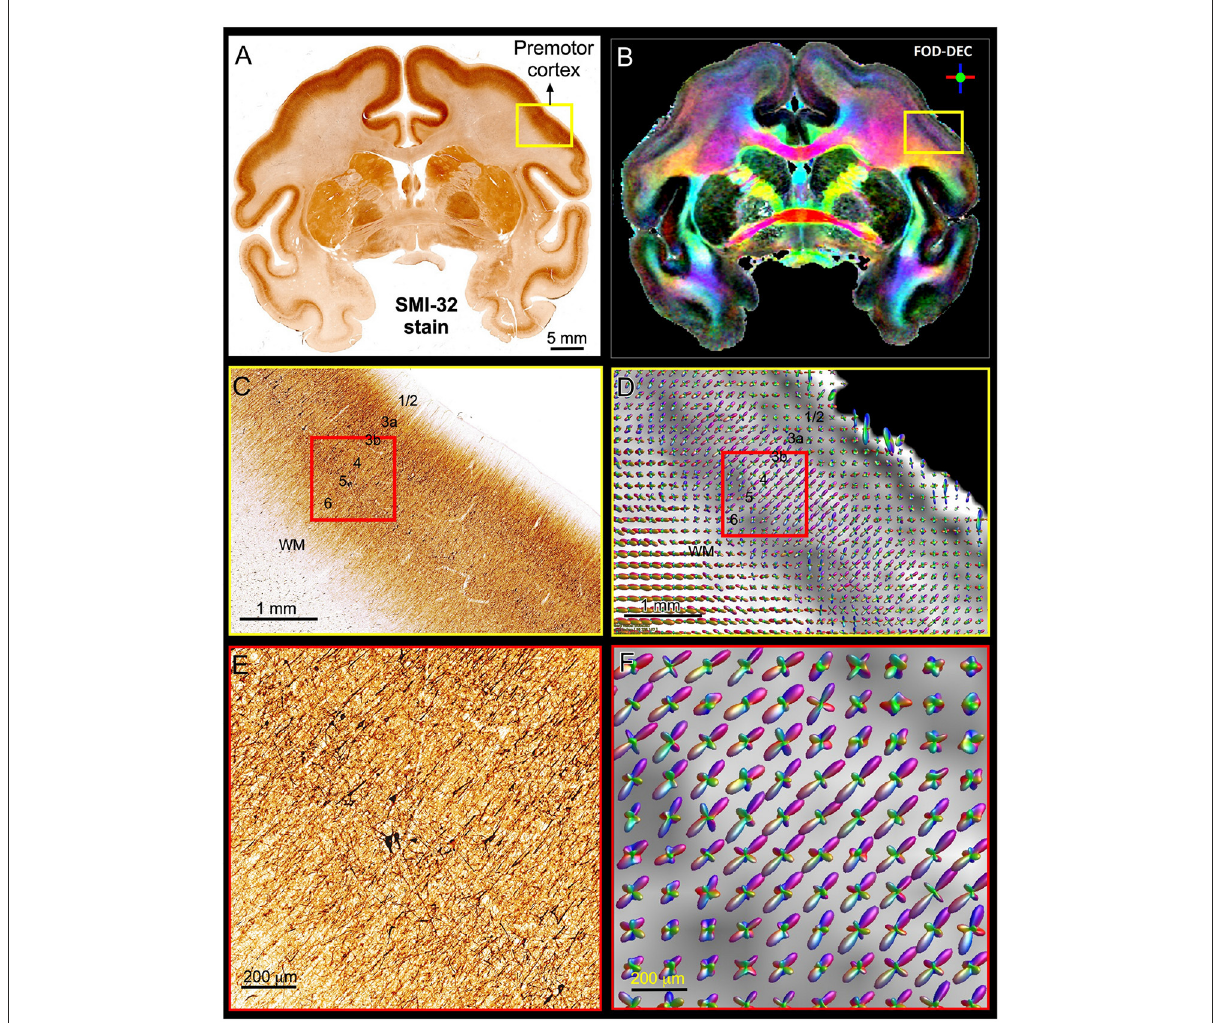
FIGURE5 Views of the brain anatomy at the macroscopic scale in a coronal tissue section stained with SMI-32 (A) and the FOD-DEC image in a matched MRI slice (B) showing the dependence of the principal diffusion direction on the cortical folding geometry. (C,D) : Enlarged views of the mesoscopic scale of the histological image and FOD glyphs corresponding to the yellow outlines in (A,B) , respectively. The cortical architecture shows a laminar pattern of radially coherent cell processes with different densities (labeled cortical layers). (E,F) : Enlarged views of the histological image and FOD glyphs corresponding to the red outline in (C,D) . The locally coherent alignment of FOD peaks (F) matches the microstructural tissue architecture comprising radial and tangential cell processes (E)